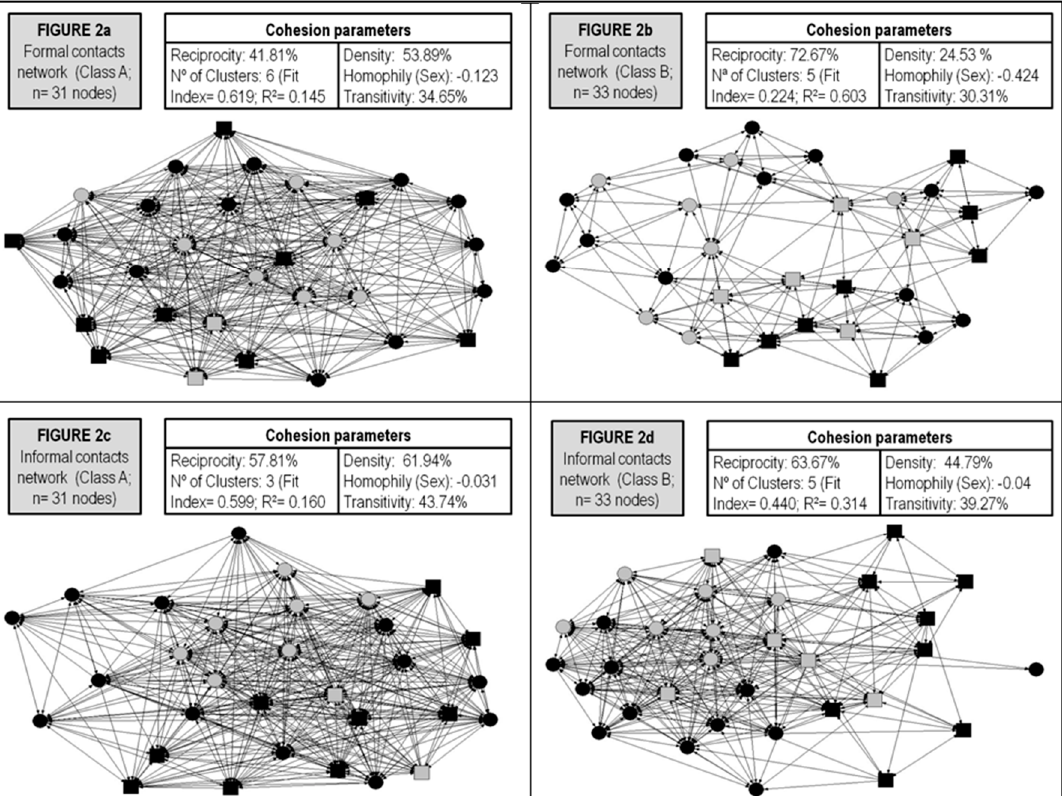
Figure 2. Structural properties of the four networks under study. Note 1: The color of nodes represents the sex of participants (Black nodes = Women. Grey nodes = Men). Note 2: The shape of nodes represent the participants’ origin (Circle = Locals. Square = Foreigners).